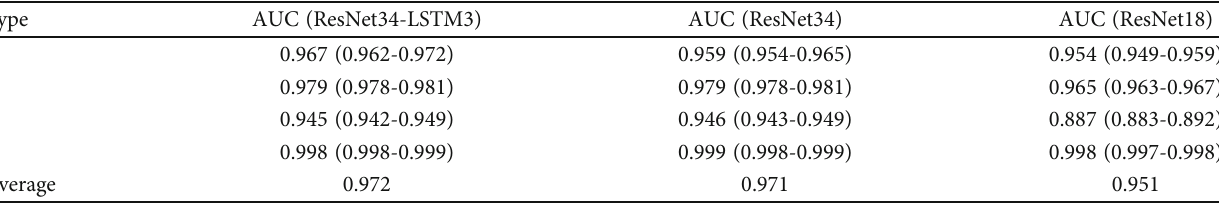
Table 6: AUC scores of the three